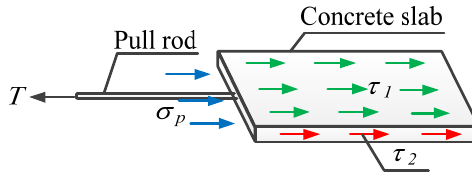
Figure 16. Force diagram of the anchor-plate.